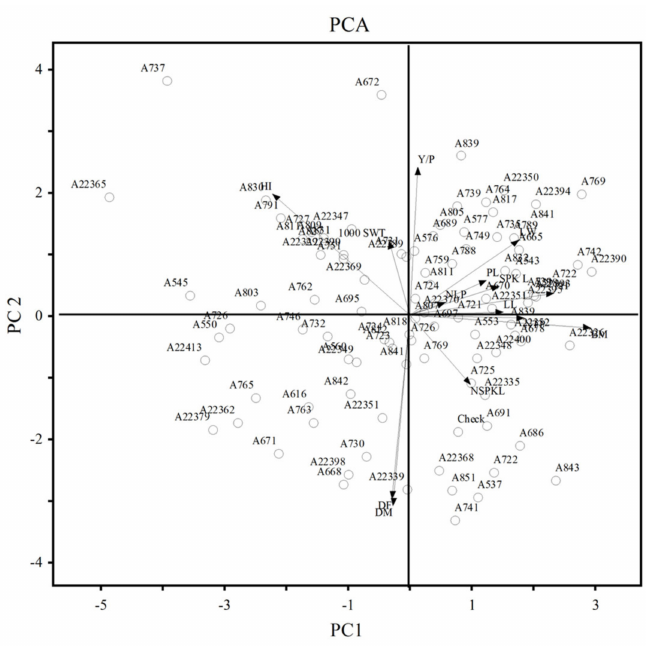
Figure 2. Scatter plot diagram of principal component analysis using different quantitative traits of Oat ( Avena Sativa L.) germplasm